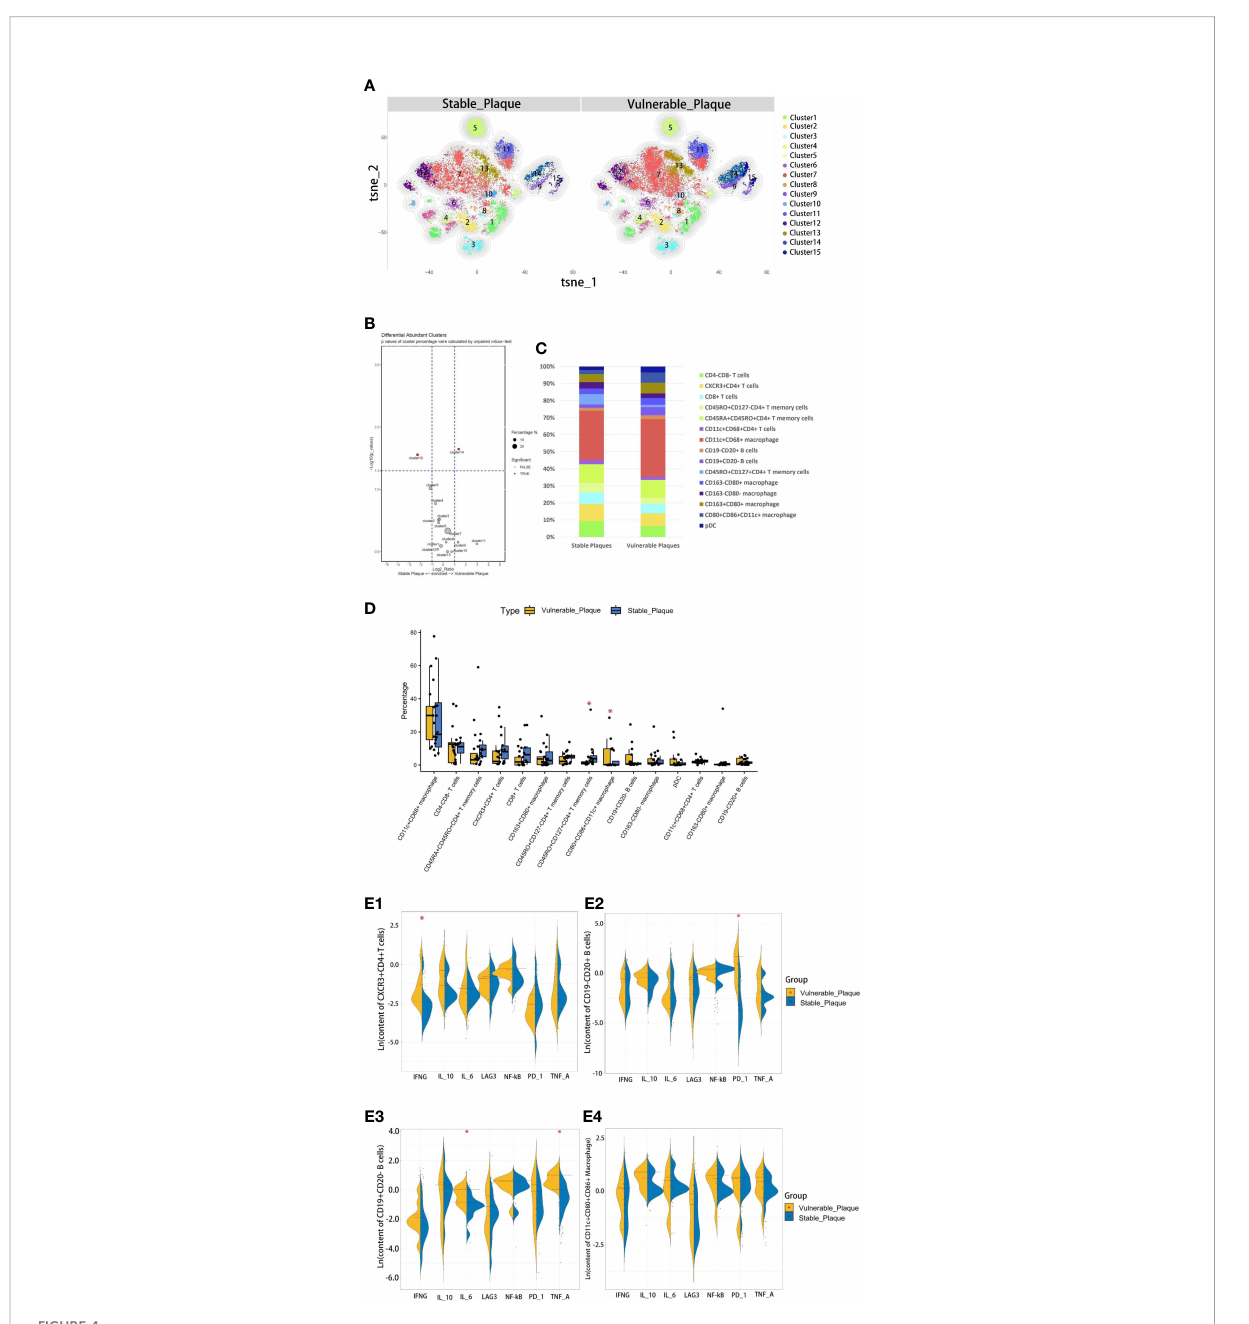
FIGURE 4 Comparison of cellular components in stable plaques and vulnerable plaques. (A) T-SNE plots of clusters were displayed for representative stable and vulnerable plaques. (B) The accumulation histogram showed the proportion of each cell subset in two types of plaques. (C) SPADEVizR method was used to analyze and present cell composition differences between vulnerable and stable plaques. (D) Bar graphs showing the changes in abundance of the cell populations identi fi ed in the t-SNE clustering, between vulnerable and stable plaques (Asterisks represented subsets of cells that were statistically different). (E) (1-4): The levels of functional molecules expressed by the same cell subsets within the vulnerable plaques and stable plaques (Asterisks represented subsets of cells that were statistically